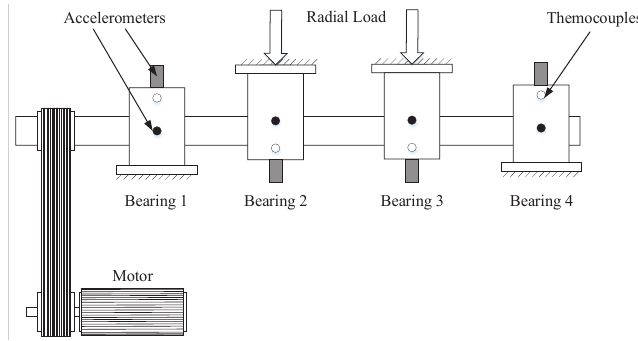
Figure 3. Bearing test-to-failure experiment system.